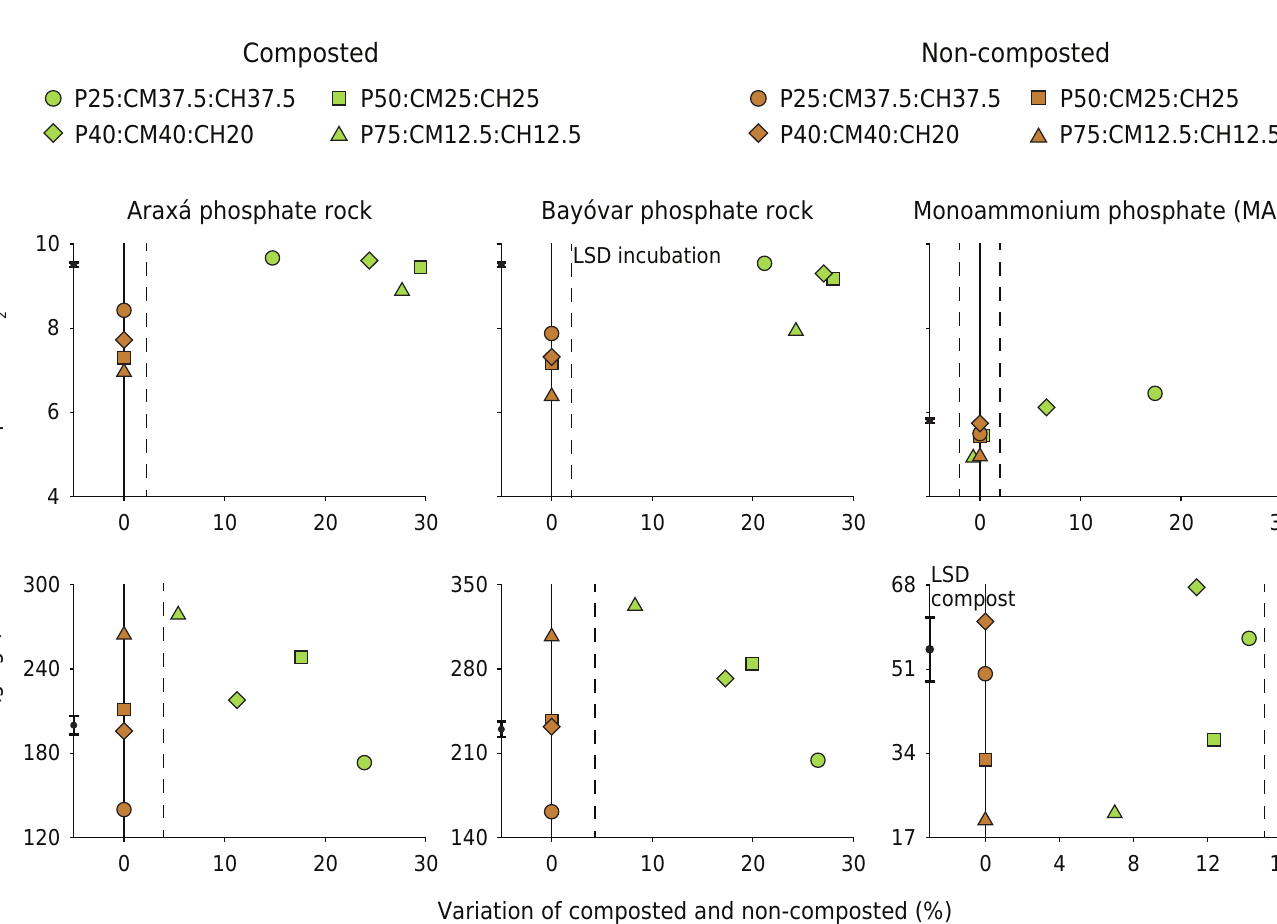
Figure 3. pH in CaCl 2 and total Ca content in composted mixtures (150 days of incubation) and non-composted mixtures (without incubation) for different proportions of chicken manure (CM), coffee husk (CH), and Araxá phosphate rock, Bayóvar phosphate rock, or MAP. LSD: Least Significant Difference by the Tukey test (p<0.05) for compost and